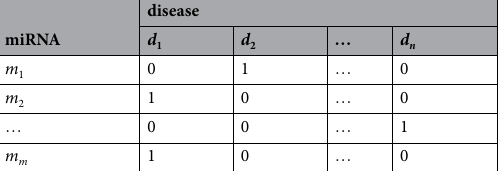
Table 3. miRNA-disease